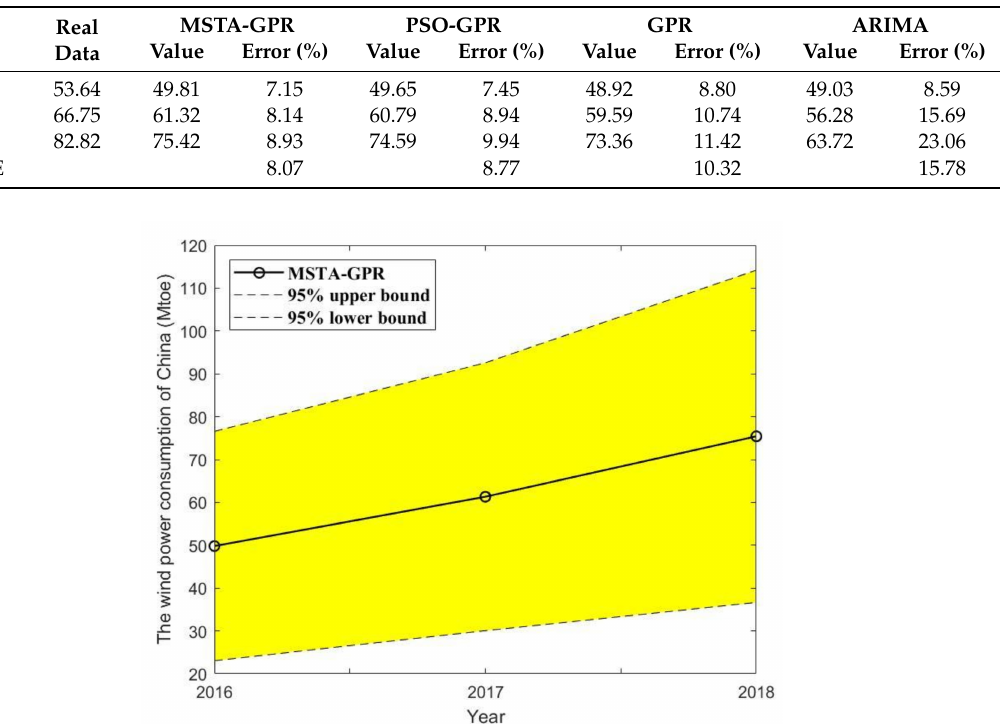
Table A2. Wind power consumption data for China from 2016 to 2018 (Mtoe).